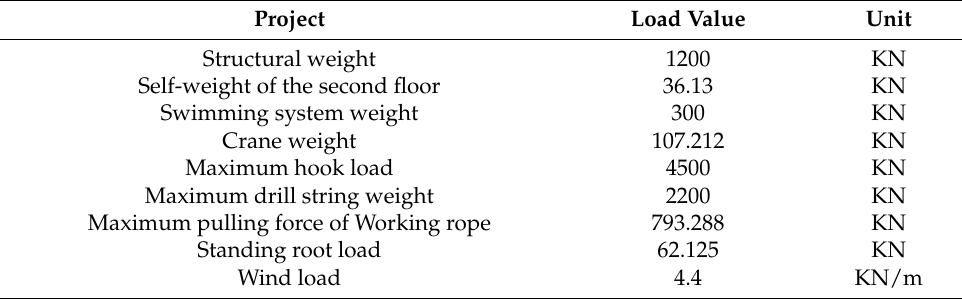
Table 1. Basic parameters of the derrick.